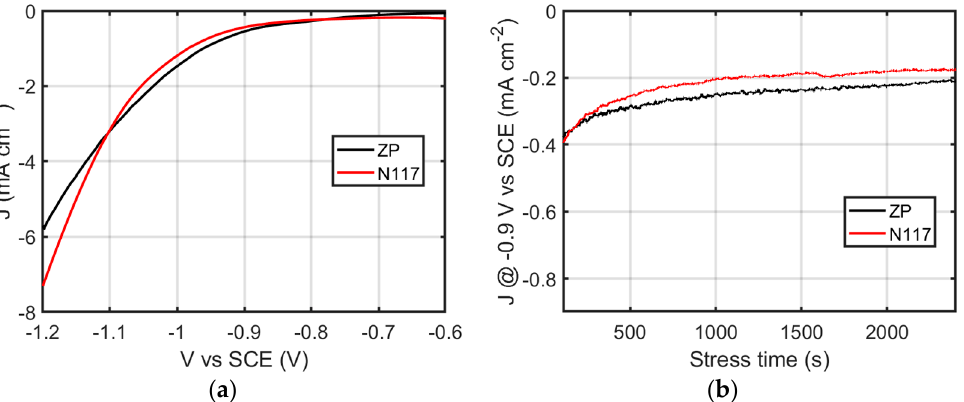
Figure 6. Linear sweep voltammetry performed in an H-cell with anode and cathode compartments separated by Nafion (N117) or Zirfon membranes ( a ). Chronoamperometry of the Au-loaded Ni foam performed at − 0.13 V vs. RHE ( b ).